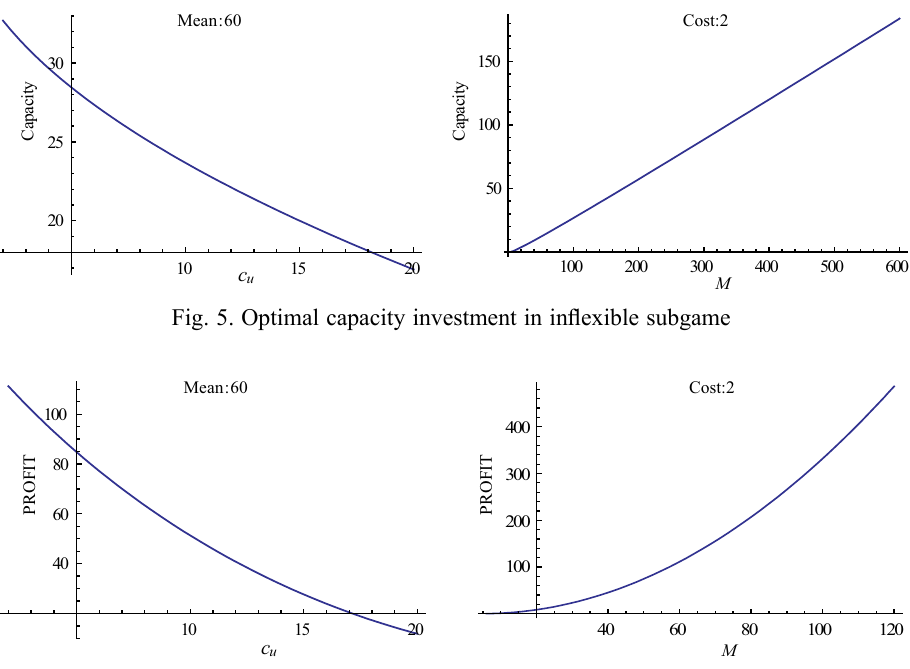
Fig. 6. Optimal profit in inflexible